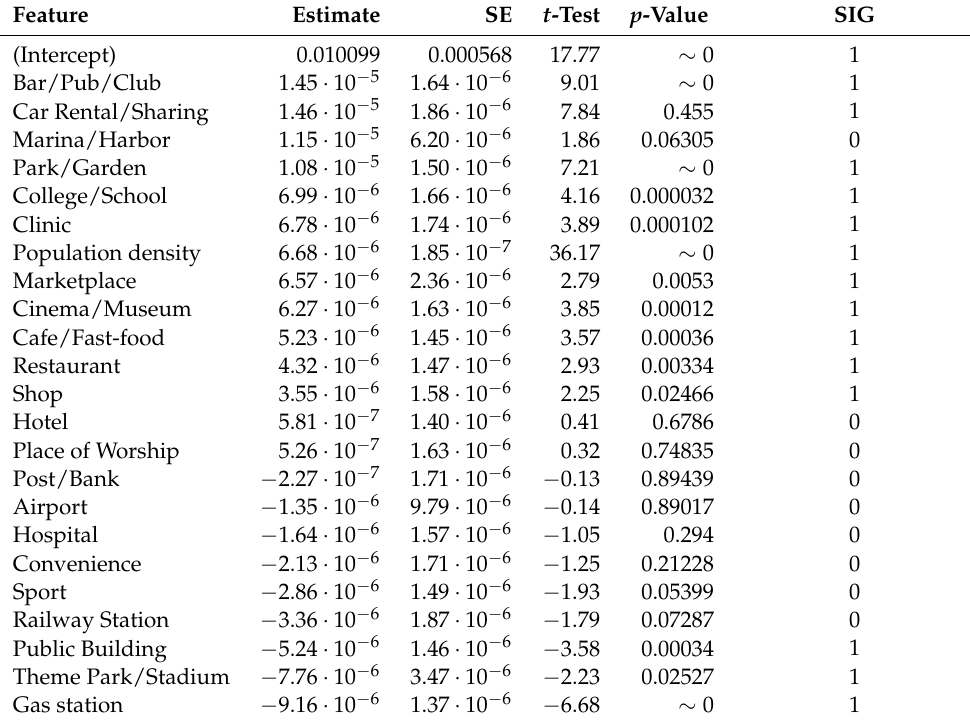
Table 1. Results of the regression analysis with marked significance ( p < 0.05); R 2 = 0.175, Along with the estimates ( b -Values) the standard error SE , t -test and p -value is